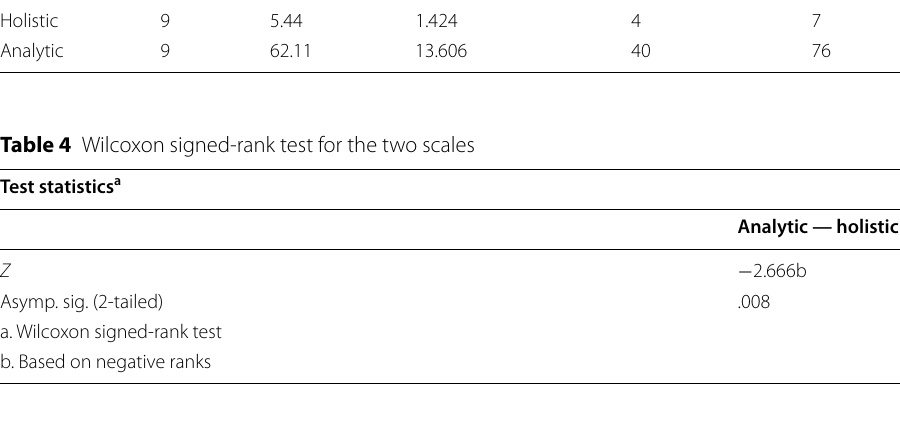
Table 3 Descriptive statistics of holistic and analytic scales scores in this study Descriptive statistics N Mean